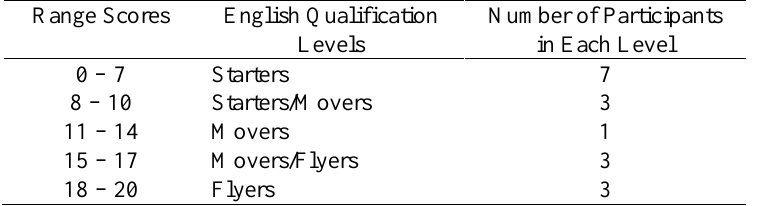
Table 1. Participants’ Cambridge English Qualification Levels